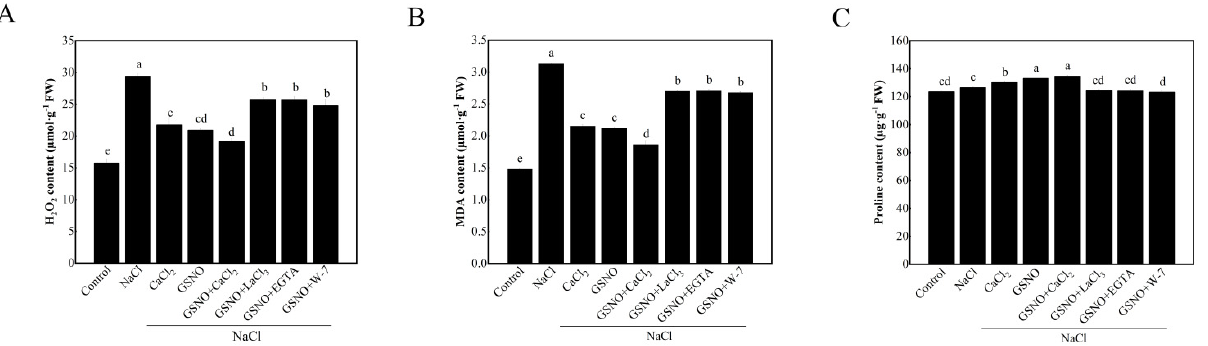
Figure 3. The content of H 2 O 2 , MDA, and proline in tomato seedlings under salt stress. ( A ): H 2 O 2 content; ( B ): MDA content; ( C ): proline content. The values (means ± SE) are the averages of three independent experiments ( n = 15). The columns labeled with different small letters indicate significant differences between treatments by Tukey’s multiple comparison test ( p < 0.05).